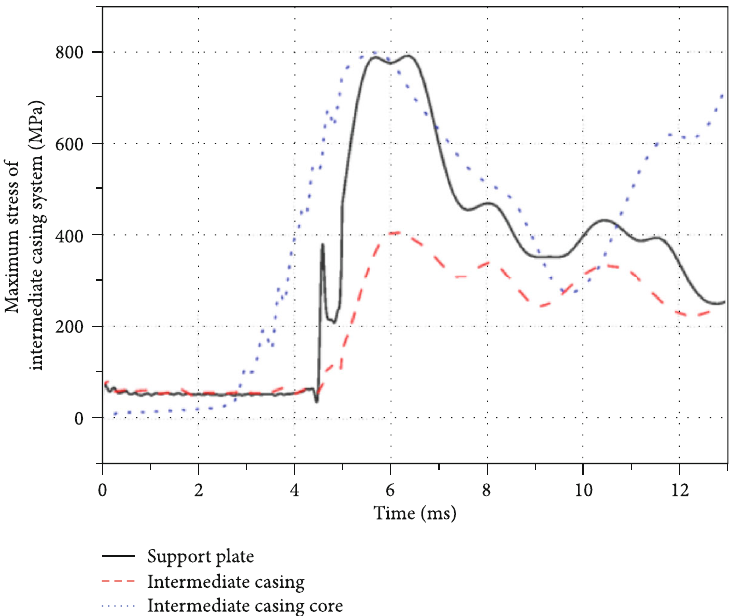
Figure 14: Stress variation of the support plate component of the intermediate